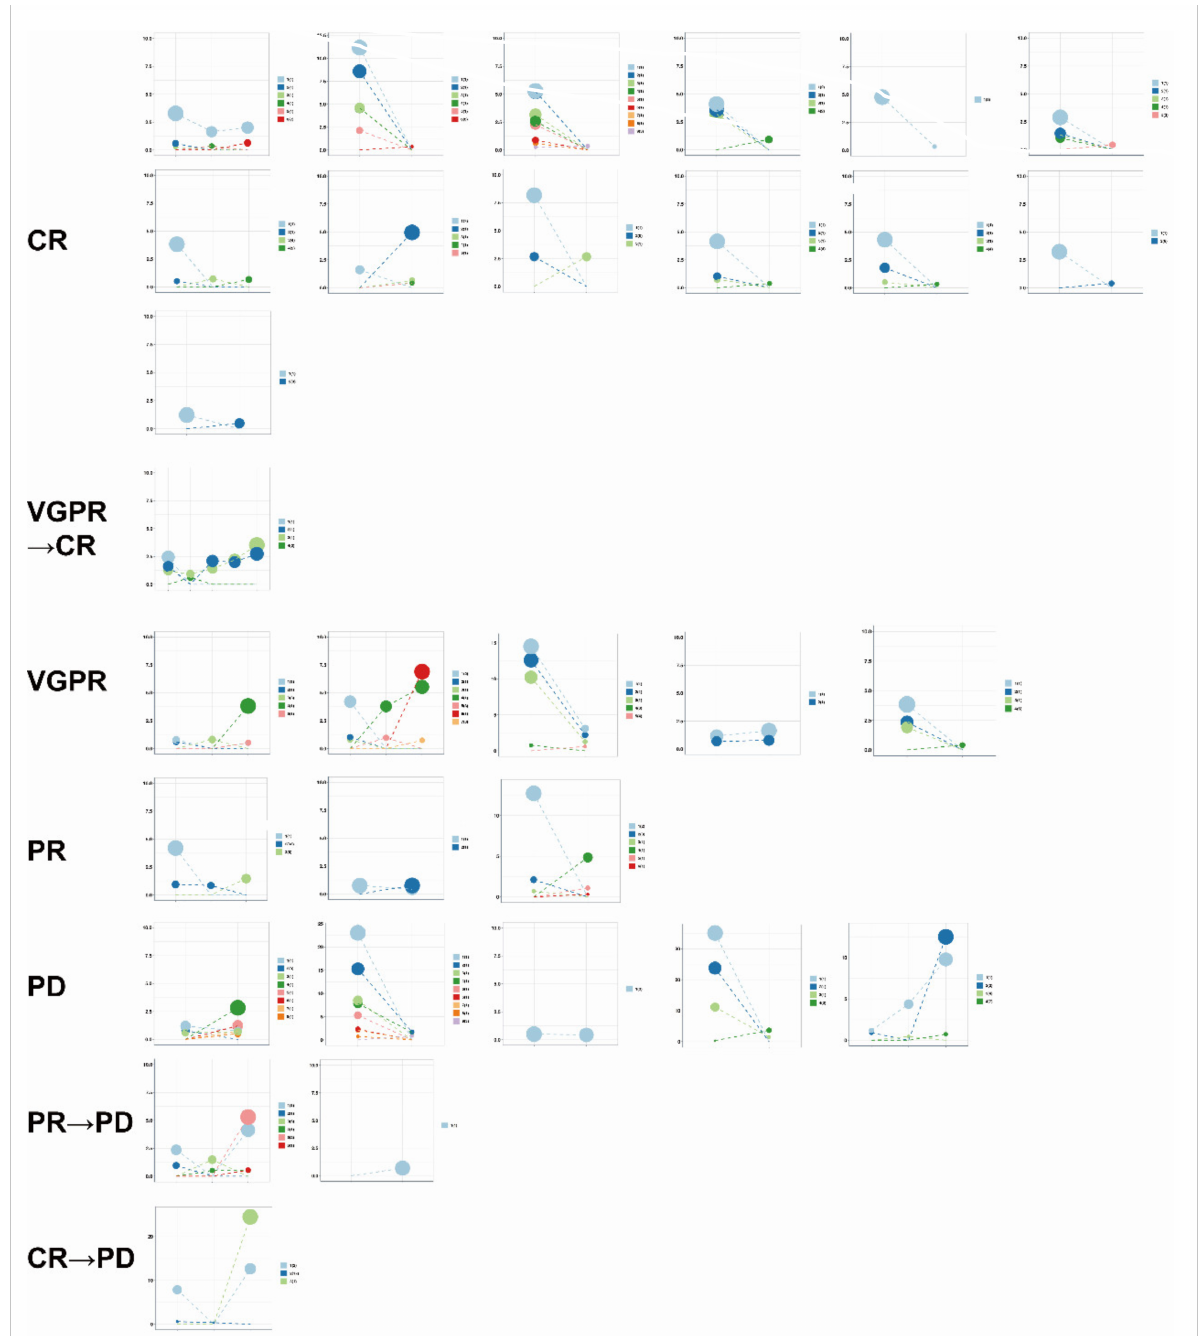
Figure 7. Clonal evolution before and after therapy according to different therapeutic responses. PyClone was employed to analyze the clonal structure using a Bayesian clustering method. For serial ctDNA, multiple inputs of each sample were used to analyze the serial clonal population. Each mutation’s CCF (cancer cell fraction) was calculated in ctDNA samples before and after therapy. The cluster with the highest CCF was identified as the clonal cluster, and mutations in this cluster were clonal mutations. Meanwhile, other clusters and mutations were considered subclonal. Each dot indicated one cluster, and a load of clusters was calculated with the mean VAF of each mutation that was